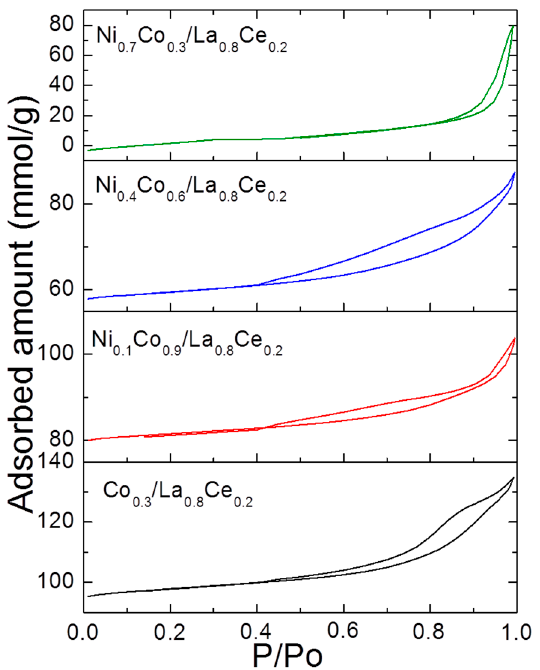
/ La 0.8 Ce 0.2 catalysts. Materials 2019 , 12 , x FOR PEER REVIEW